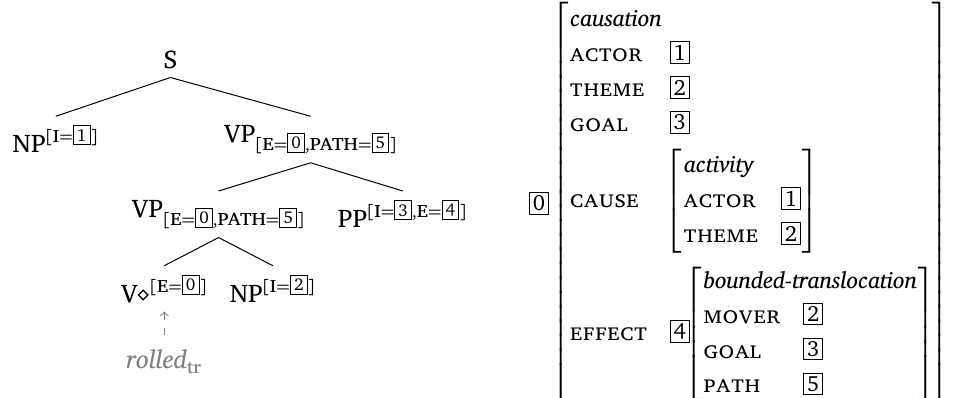
Figure 2: Tree template and frame-semantic representation of the transitive motion construction from Figure 1, taken from Kallmeyer and Osswald (2013, Fig.